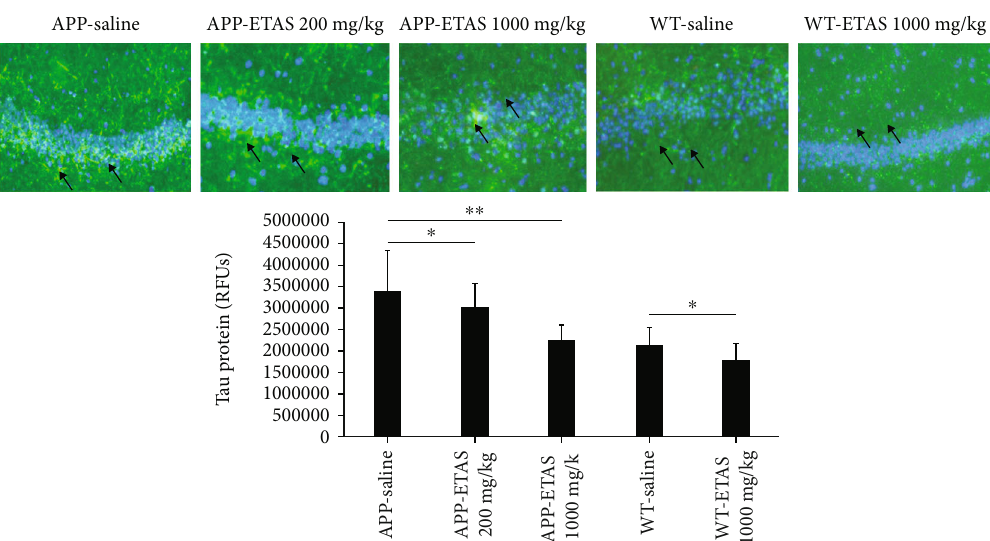
Figure 7: Quanti fi cation of tau protein in the hippocampus of APP-overexpressed mice treated with ETAS (200mg/kg and 1000 mg/kg) and WT mice treated with ETAS (1000mg/kg) for 1 month, respectively. ∗ p < 0 : 05 APP-ETAS (200mg/kg) vs. APP saline-treated mice; ∗∗ p < 0 : 01 APP-ETAS (1000mg/kg) vs. APP saline; ∗ p < 0 : 05 WT-ETAS (1000mg/kg) vs. WT saline-treated mice; RFUs: relative fl uorescence units. Four mice per group and four sections per mouse were used. Green represents tau protein, and blue represents DAPI. Arrows represent fl uorescent green staining, indicating positive expression. Magni fi cation is represented × 200.